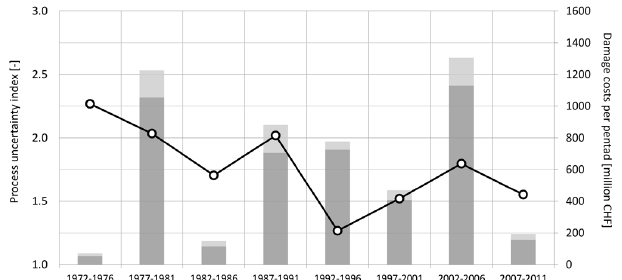
Fig. 5. Process uncertainty index for all bedload damage cost esti- mations per pentad (index describes data quality and was assessed using the upper damage estimates for weighting single database en- tries). The lower the index, the more reliable the information on the damage process. The grey bars in the background indicate the accumulated bedload damage costs per pentad (lower and upper es-